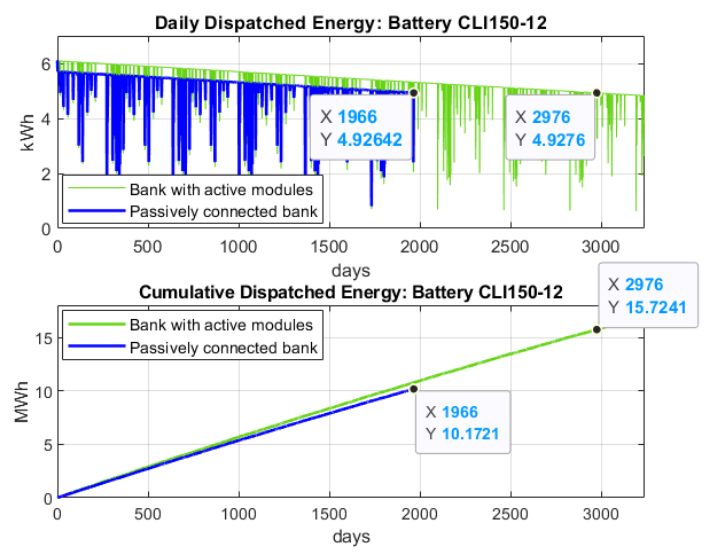
Figure 17. BESS performance comparison: Lead-Acid Batteries.